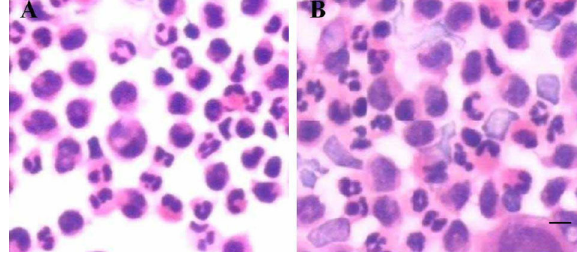
Figure 2. Chemotactic activity of monocytes detected by Transwell chamber assay was at a low level in the stable angina pectoris group ( A ) and was significantly enhanced in the unstable angina pectoris group ( B ). Scale bar: 50 m